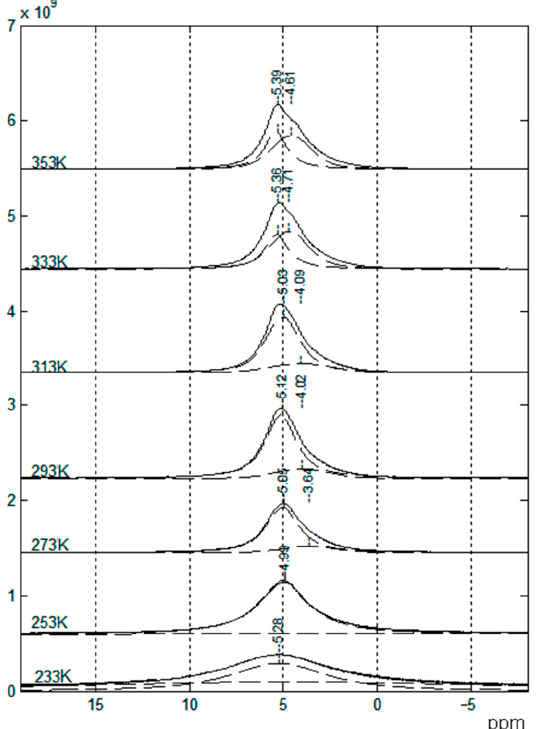
Figure 18. 1 H NMR spectra of SPE no. 9 at different temperatures [53].